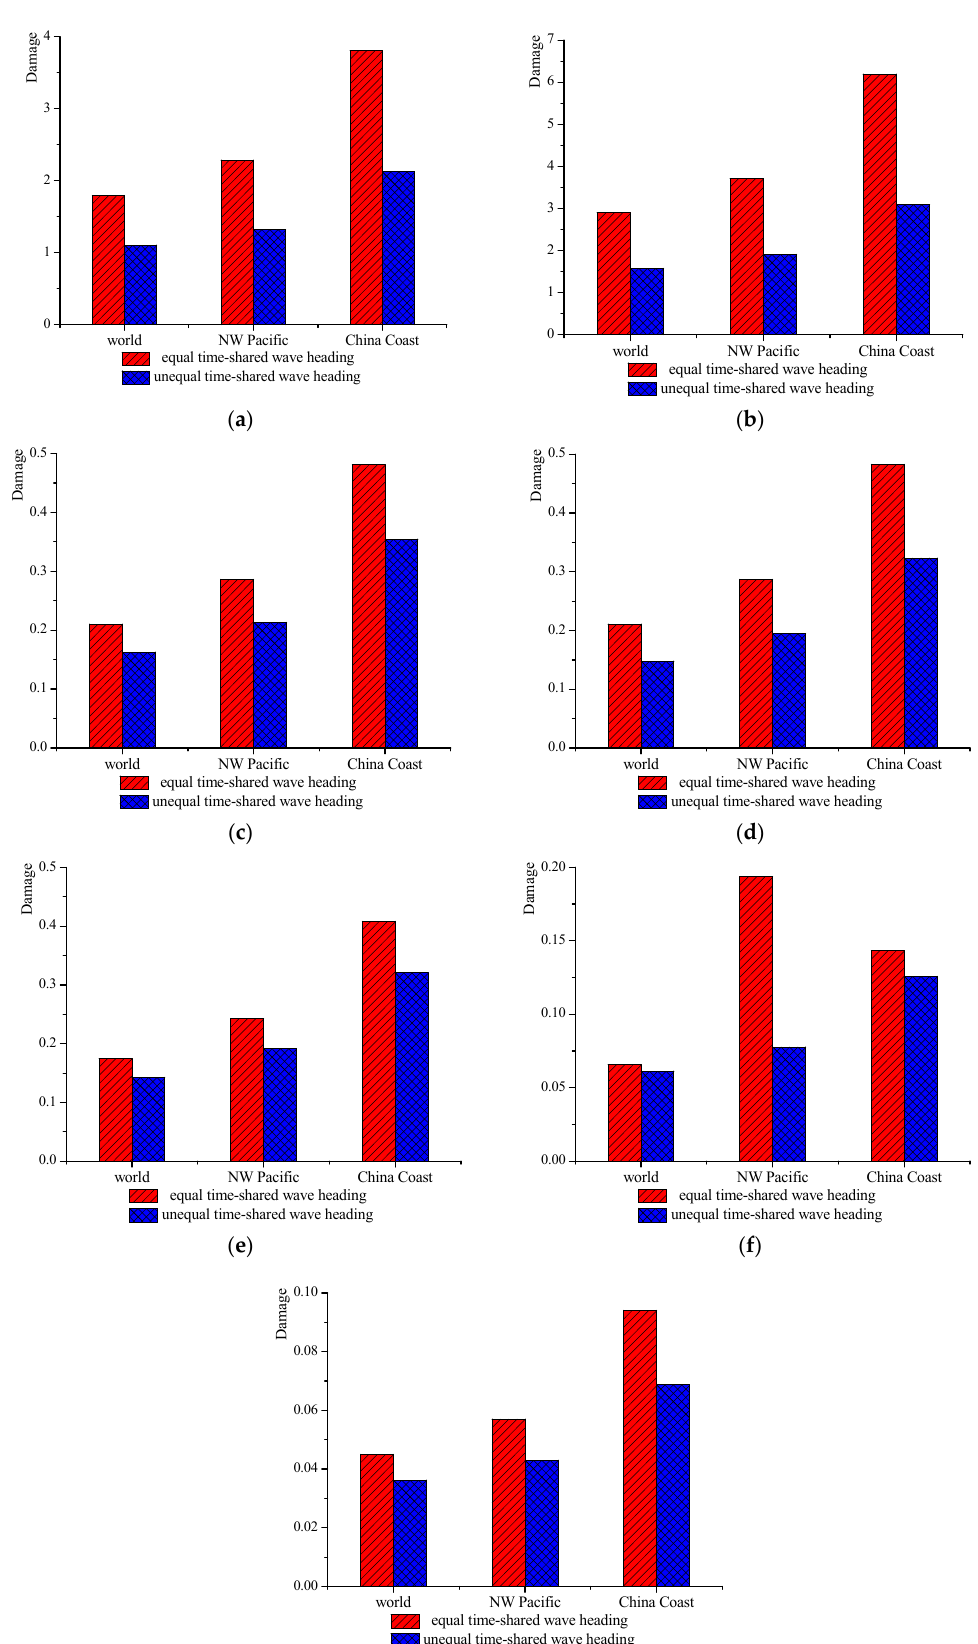
Figure 10. Results of fatigue damage calculation as follows: ( a ) Hot spot 1, ( b ) hot spot 2, ( c ) hot spot 3, ( d ) hot spot 4, ( e ) hot spot 5, ( f ) hot spot 6, and ( g ) hot spot 7. Figure 10 demonstrates that the fatigue cumulative damage values of hot spots 1 and 2 are greater than other hot spots, which indicates that the connection between the main hull and cross-deck at the front has a serious fatigue problem. Since the main hull is the main load bearing structure in the trimaran, the load on the side hulls is very small, due to its smaller hulls. The very small stress transfer function values of hot spot 7 (Figure 3g) prove this statement. For these reasons, the cumulative fatigue damage value of hot spot 7 is the smallest of all hot spots. The fatigue cumulative damage values of hot spots 3, 4, 5, and 6 are large, which are mainly caused by the splitting moment and transverse torsional moment. This finding is different from that of a conventional ship form, which cannot be ignored. Figure 10 shows that, under either equal or unequal time-shared wave headings, the fatigue cumulative damage values, using the China Coast wave scatter diagram, are larger than using the Northwest Pacific and World Wide Trade wave scatter diagrams. The main reason for this is that the waves along the China Coast are mainly concentrated in the medium wave level, which contributes more to fatigue damage. The characteristics of the stress transfer function (shown in Figure 3) are another reason for the larger fatigue cumulative damage values in this area. Figure 10 also shows that fatigue cumulative damage values, considering unequal time-shared wave heading distribution coefficients, are smaller in each wave scatter diagram. Since we use the time allocation ratio of 50% head sea and following sea, 25% beam sea, and 25% oblique sea, the beam sea and oblique sea appear to contribute more to fatigue damage. This is the specific fatigue characteristic of a trimaran due to its special cross-deck structure. Figure 11 illustrates how the P S N curves of survival rate 97.7%, obtained from full-scale model fatigue testing, correlate with the cumulative fatigue damage values of hot spots 1 and 4. world